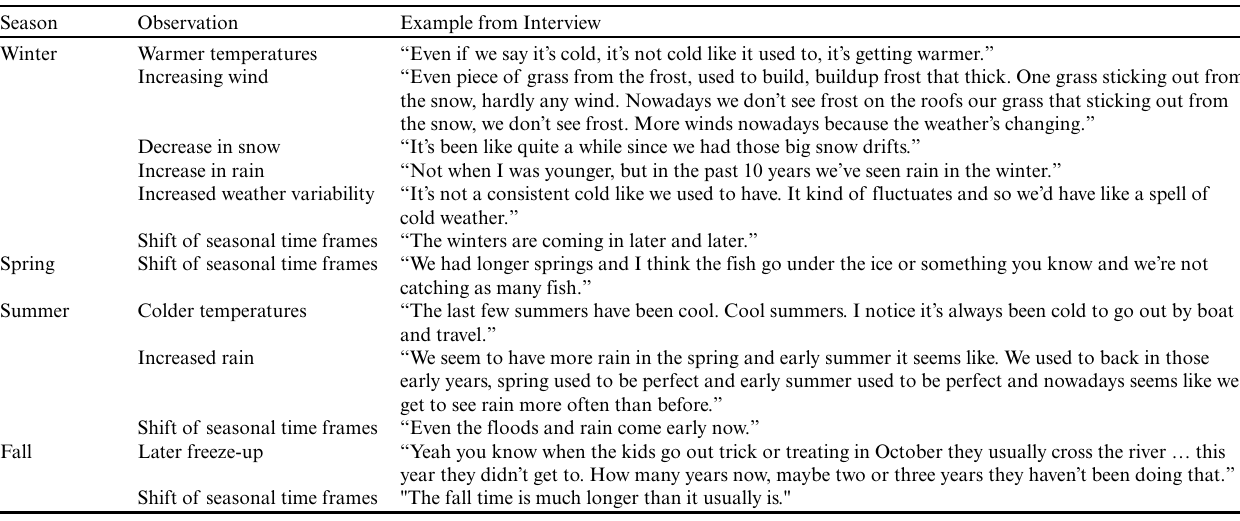
Table 1 . Common observations across all age cohorts and communities.